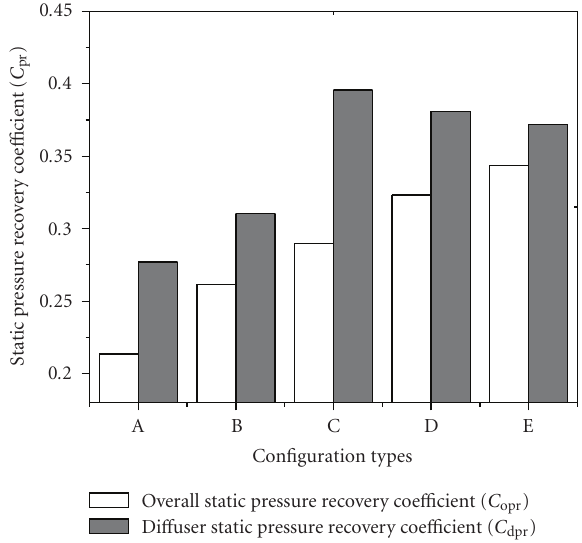
Figure 11: Static pressure recovery coe ffi